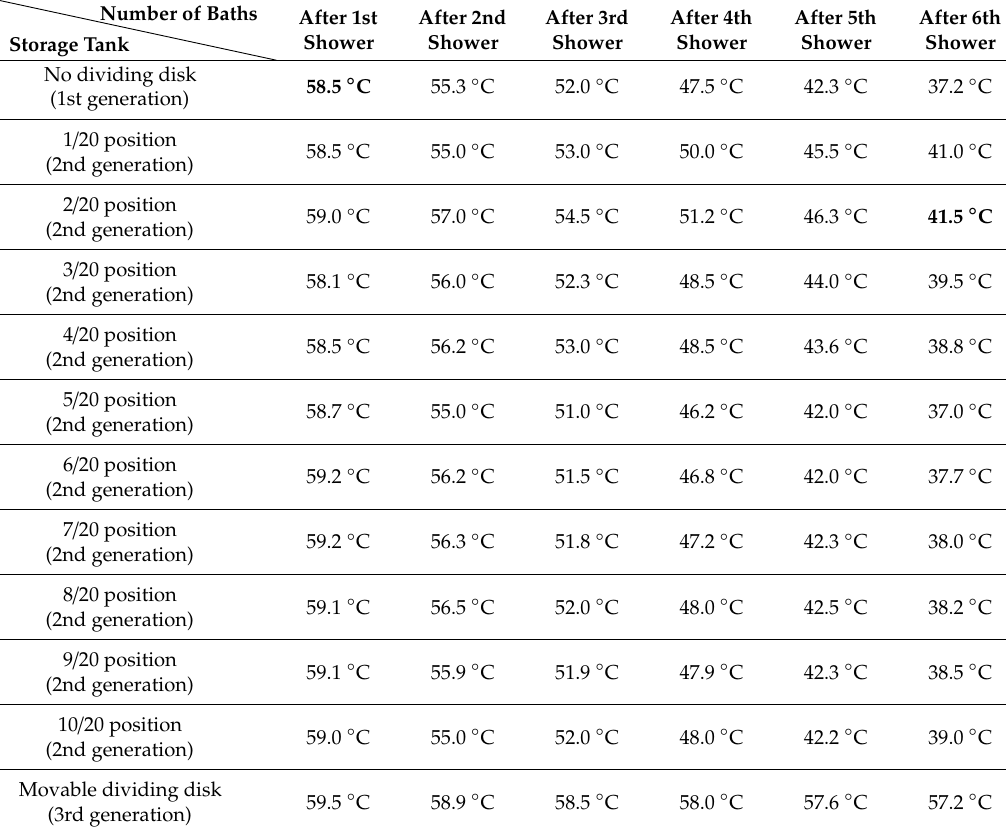
Table 3. Results of hot water experiments on simulation of various tanks from the 1st to the 3rd